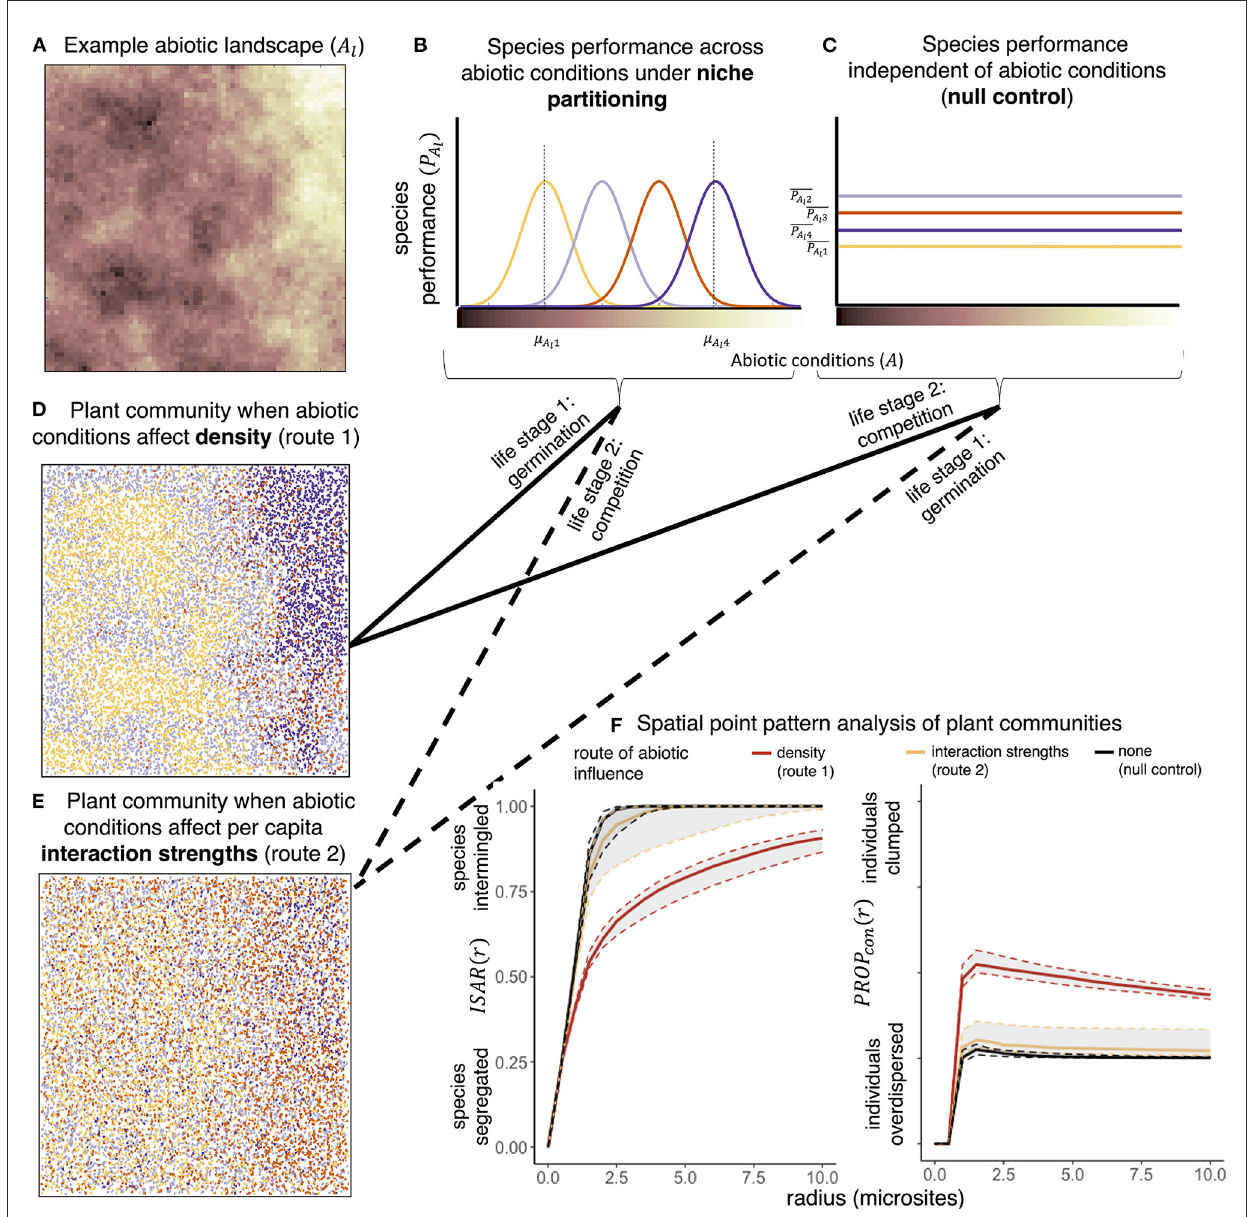
FIGURE2 When (A) abiotic conditions vary over a landscape, species performance, P A , may (B) depend on abiotic conditions, or (C) be independent of abiotic l conditions. Points in (D, E) represent individual plants and colors represent species visualized after 200 rounds of simulated dynamics where abiotic effects of landscape A l influenced (D) density and (E) interaction strengths. Solid arrows map how species responded to the abiotic environment during early compared to late life stages (germination and competition, respectively) when abiotic conditions influenced initial densities (route 1). Dashed arrows show the same but for route 2, when abiotic conditions determined interaction strengths. Point pattern analysis (F) across parameter space [including point patterns shown in (D, E) ] show that interspecific segregation and intraspecific clumping (quantified by the ISAR and PROP con , respectively, Supplementary Table 1) were greater when abiotic conditions affected density compared to when they affected interaction strengths (lines are median values, and shaded areas are 1.5 times the interquartile range). ISAR and PROP con values when abiotic effects were indirect overlapped with values from the null model that excluded effects of the abiotic environment on species performance. Point pattern maps (D, E) are from simulations with intermediate dispersal and α ij =